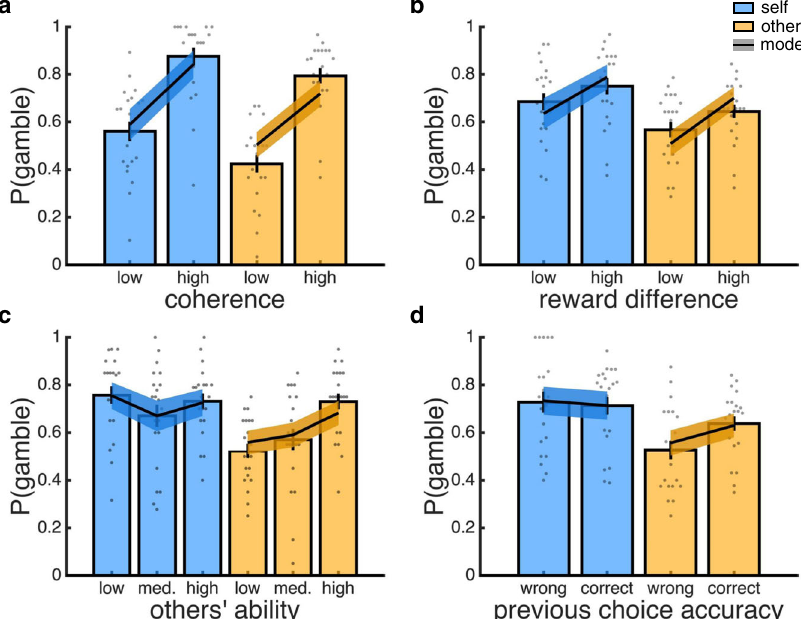
Fig. 2 Behavioural results. In each panel, data are split into self-trials (blue) and other-trials (yellow). a Probability gamble (i.e., proportion of trials in which the risky option was selected) as a function of coherence (median split). b Probability gamble as a function of the reward difference between the risky and the safe option (median split). c Probability gamble as a function of the ability of the other players. d Probability gamble as a function of choice accuracy on the previous trial of the same type. a – d Bar charts are empirical data, with individual participants overlaid as dots. Lines are data simulated under the best- fi tting model (ToM-model). Empirical and simulated data are represented as group mean ± 95% CI, n = 21. Source data are provided as a Source Data fi le.